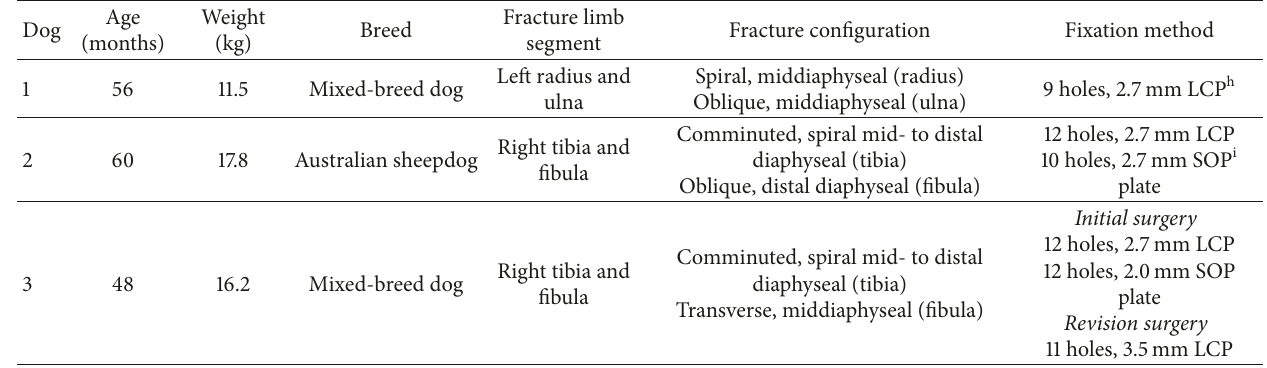
Table 1: Clinical information for three dogs with fractures stabilized via minimally invasive plate osteosynthesis facilitated by the use of the Minimally Invasive Reduction Instrumentation System.